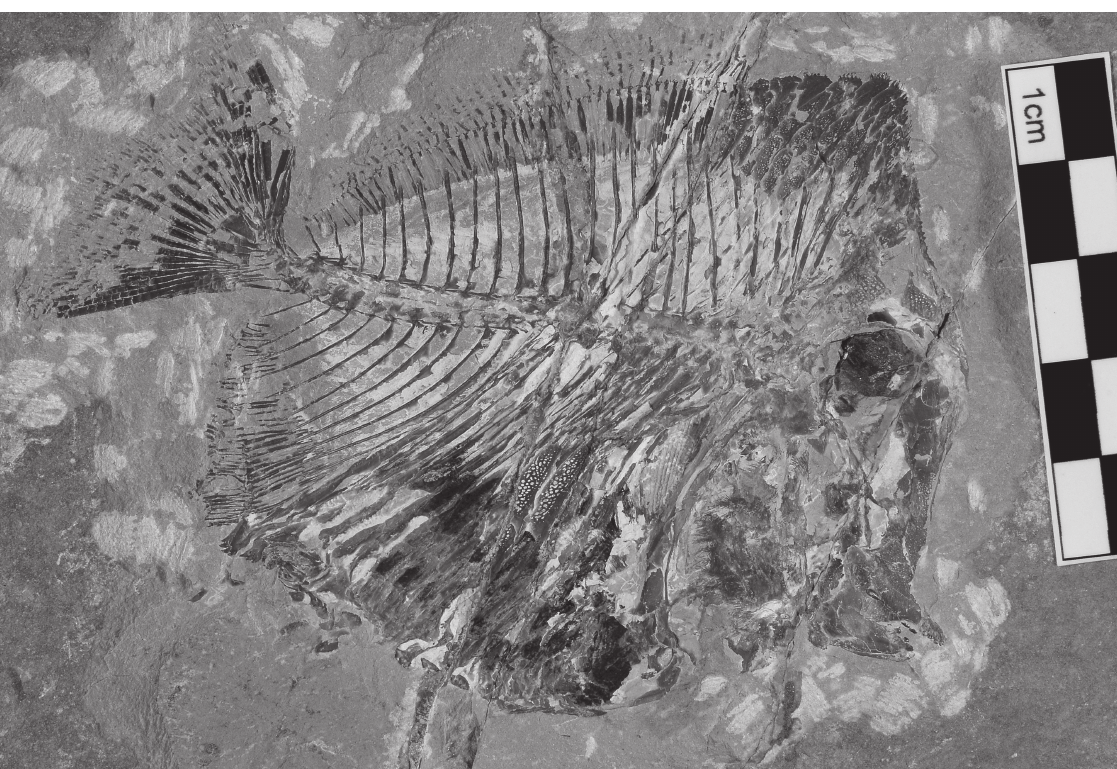
Fig. 25. Akromystax tilmachiton Poyato-Ariza & Wenz, 2005. Sample CLC S-712 from the marine Cenomanian of Haqel, Lebanon.